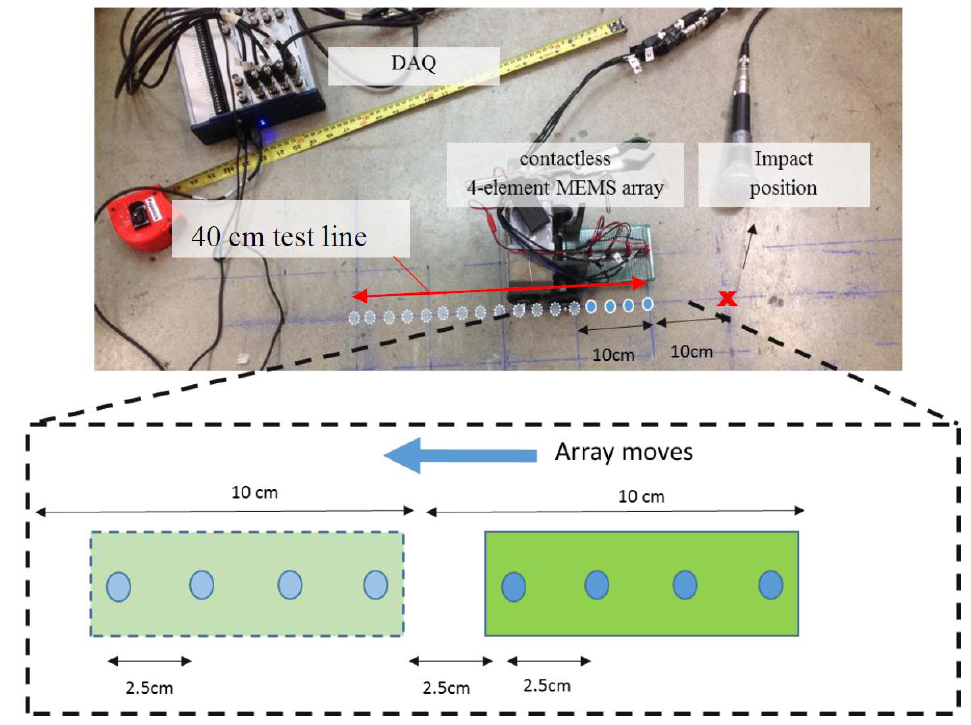
Figure 7. Seismic MASW test configuration showing air coupled sensors. Sensed positions indicated by blue